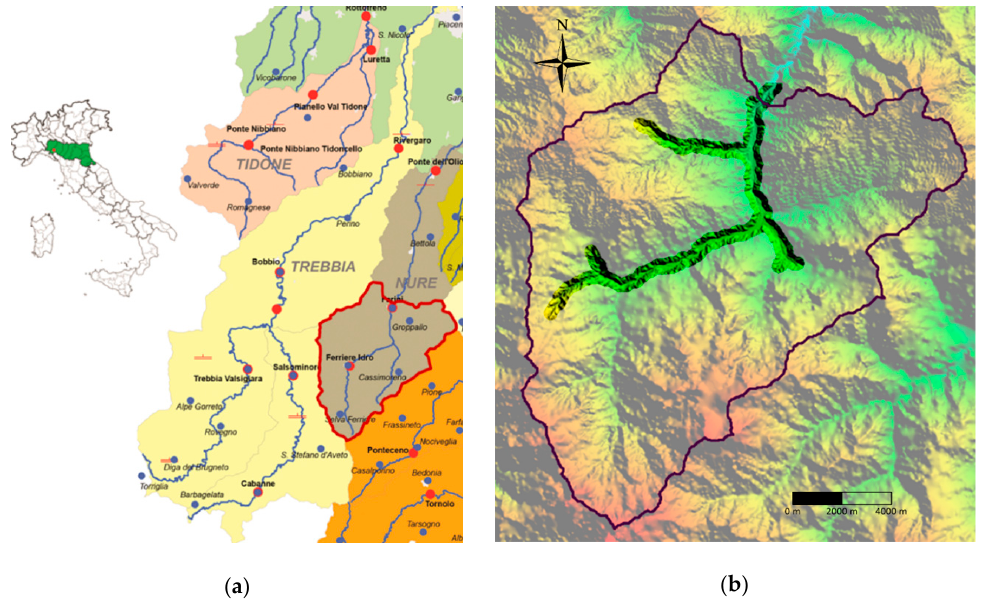
Figure 8. Nure watershed: ( a ) administrative map of Italy with Emilia-Romagna Region highlighted